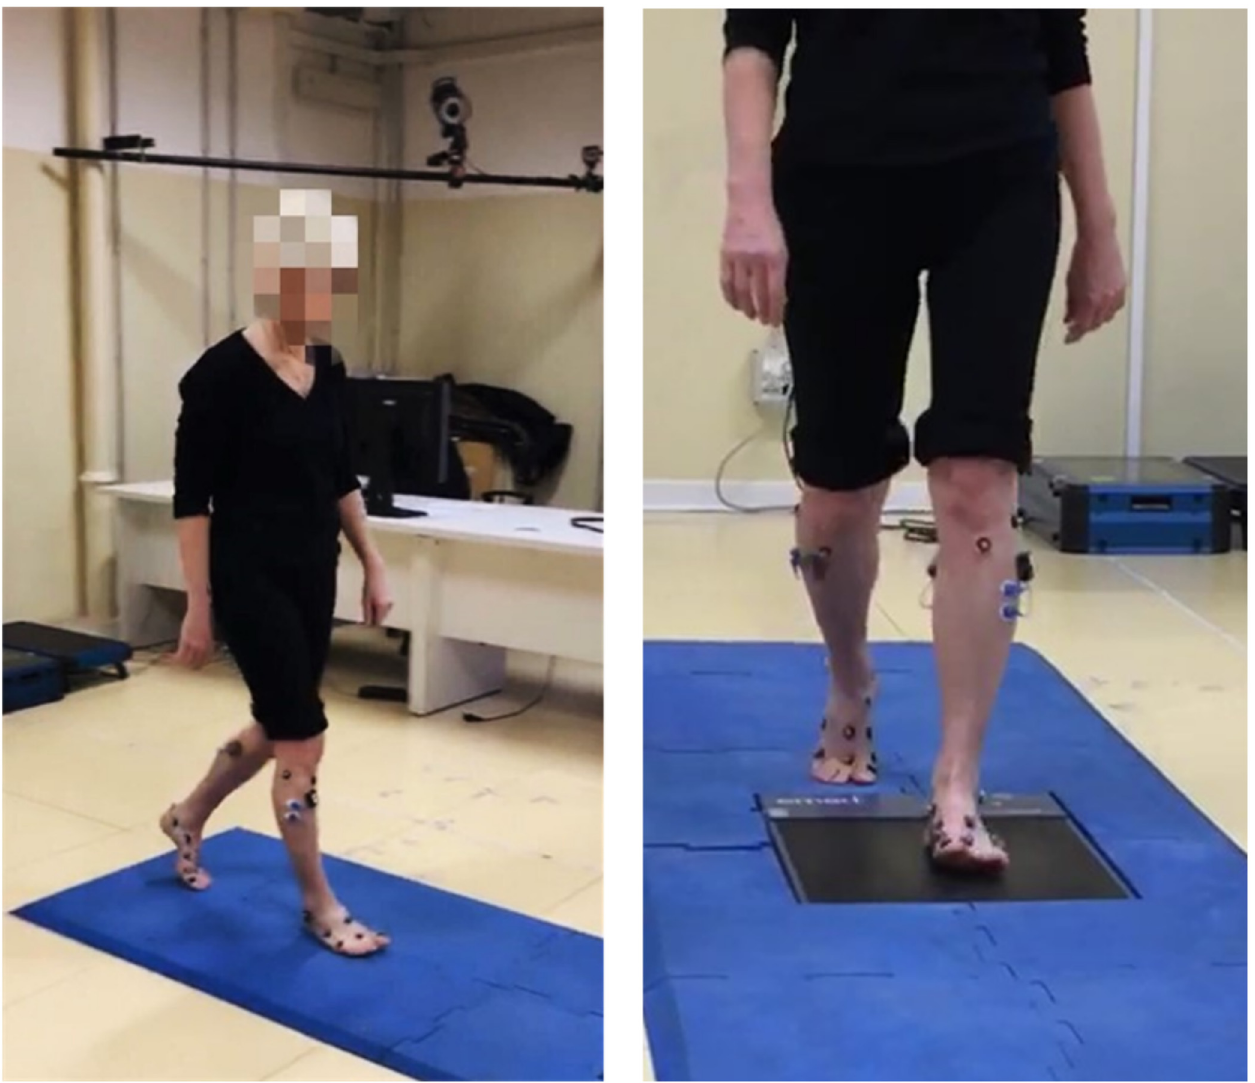
Figure 1. Exemplary walking trial for one of the participants with diabetes fitted with the Rizzoli Foot Model marker set.